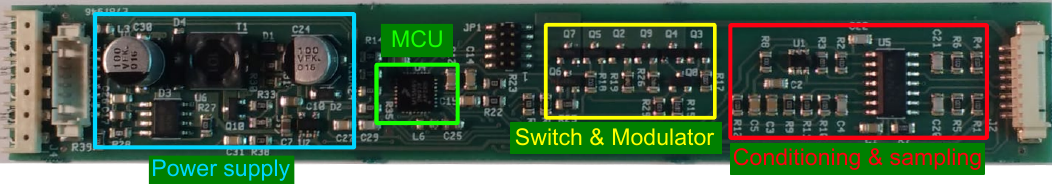
Figure 7. T8 tube control and sensing board.